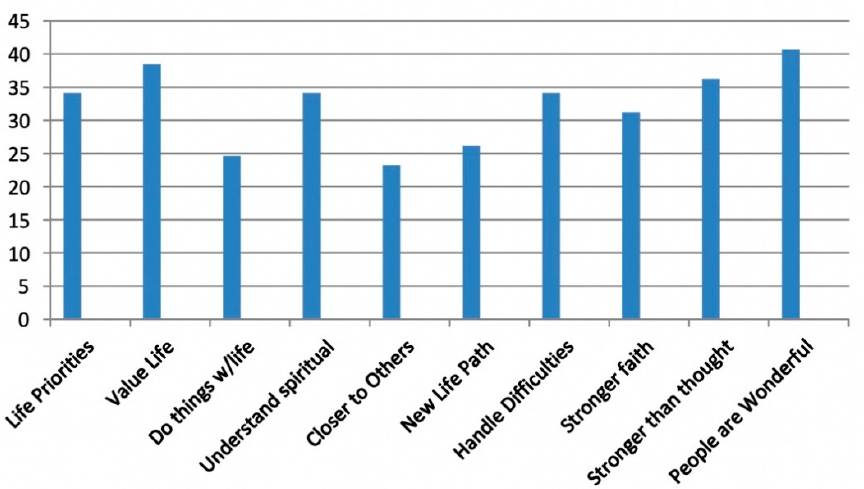
Figure 1. Posttraumatic Growth Inventory: % of Survivors Reporting Change to a Great/Very Great Degree after Bombing.